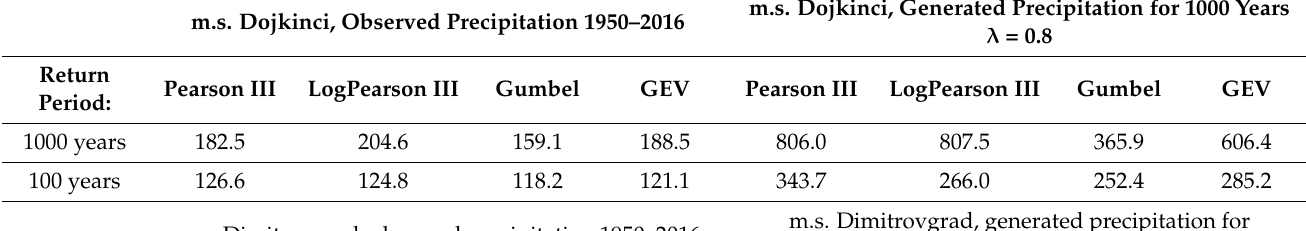
Table 1. Theoretical values of observed and generated extreme precipitation for meteorological stations